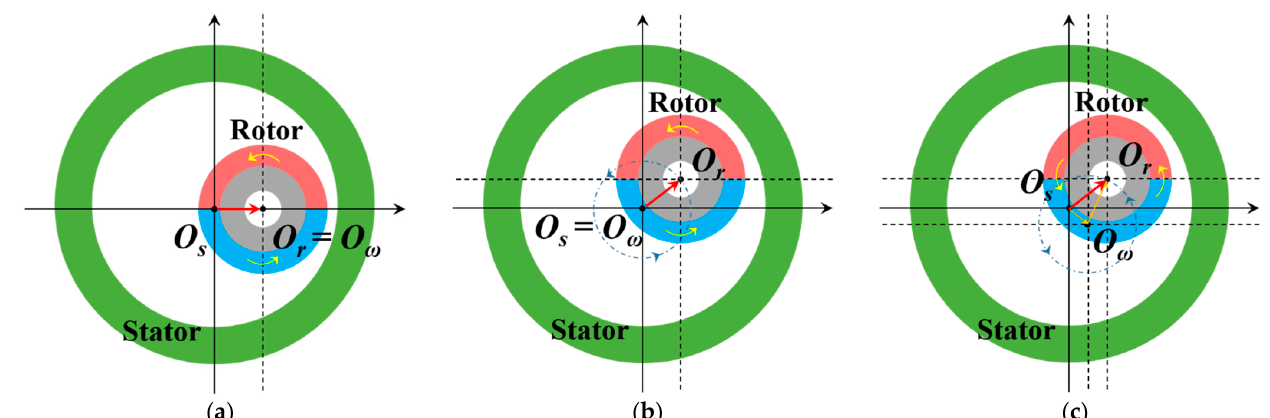
Figure 4. Positions of the stator, rotor, and rotation centers according to eccentricity: ( a ) Static eccentricity; ( b ) Dynamic eccentricity; ( c ) Mixed eccentricity.